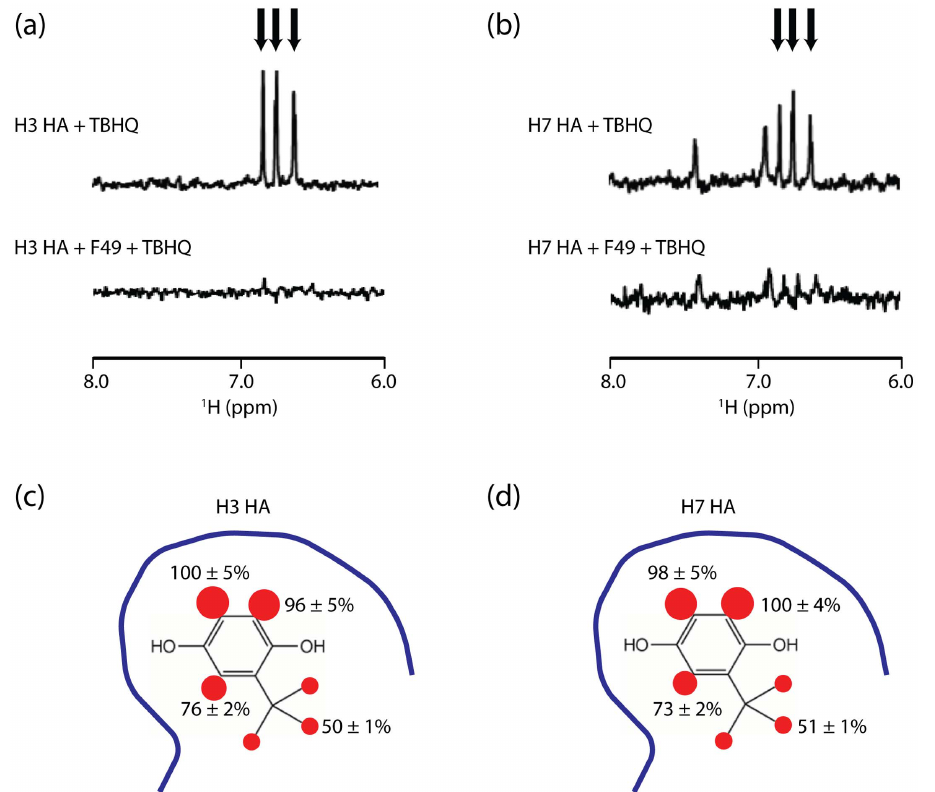
Figure 2. TBHQ binds to the H3 and H7 HA stem loops. (a) WaterLOGSY NMR of TBHQ binding to H3 HA in the presence and absence of monoclonal antibody F49. (b) WaterLOGSY NMR of TBHQ binding to H7 HA in the presence and absence of monoclonal antibody F49. In (a) and (b) the aromatic resonances of TBHQ are denoted by arrows. (c) Relative STD signals of TBHQ in the presence of H3 HA. (d) Relative STD signals of TBHQ in the presence of H7 HA. The blue line represents the protein surface. The size of the red spheres represent the magnitude of the observed STD for each 1 H.